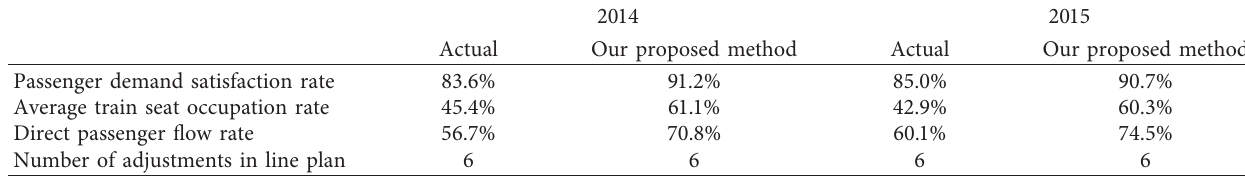
Table 3: Comparison of our results with the actual